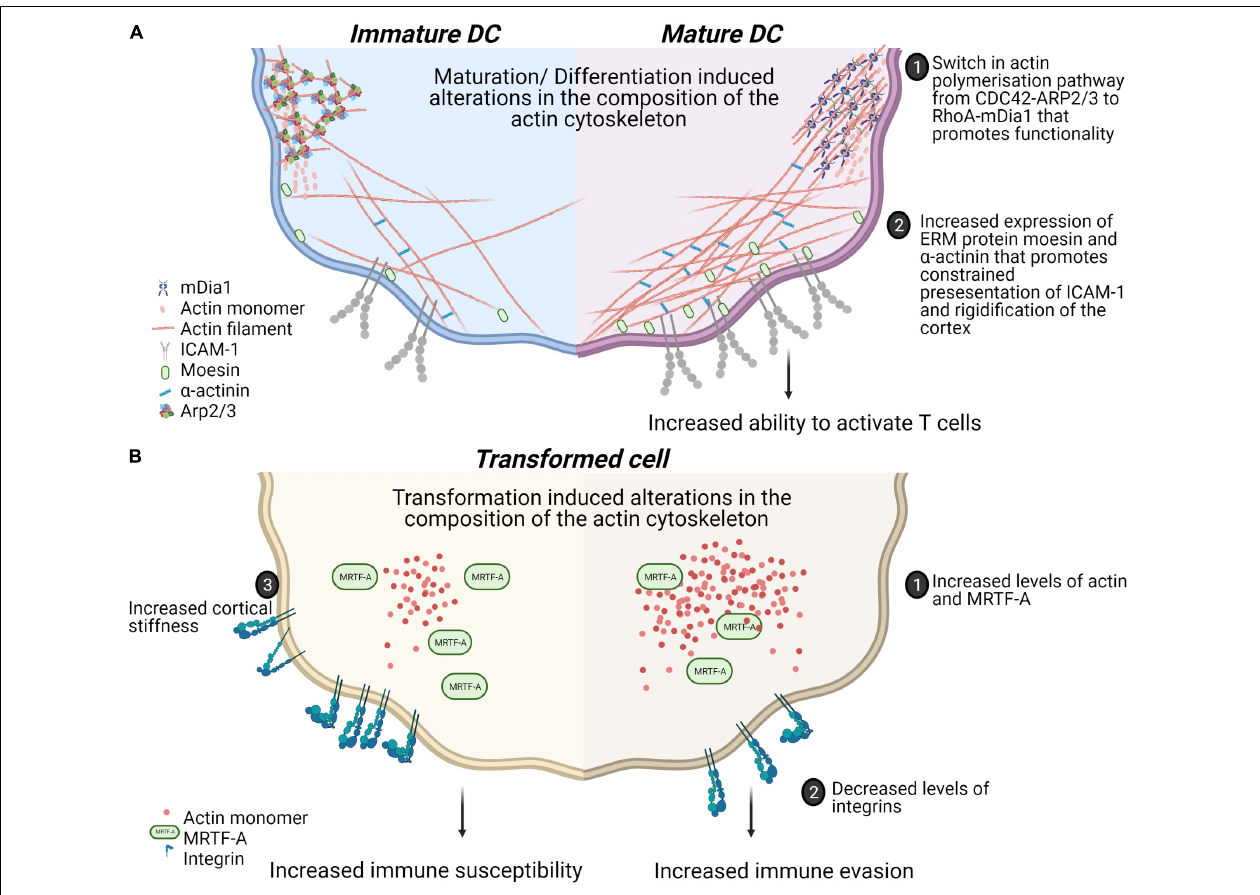
FIGURE 2 | Physiological and pathophysiological alterations in mechanical properties of immune cells alter functionality of cell-cell contacts . (A) Maturation of dendritic cells in response to Th1 polarizing antigens is associated with alterations in actin polymerization pathways. This is associated with a switch from more adherent, micropinocytosis favoring phenotype to a more migratory phenotype. These changes also include increased confinement of membrane proteins and rigidifying of the cotext that collectively enhance the activation of T cells. (B) Transformation induces changes in biophysical properties of cells through alterations in the actin cytoskeleton. Increased levels of MRTF contribute to prometastatic changes such as decreased expression of integrins and increased actin content enhancing migration. However, these adaptations could also lead to increased cortical rigidity and increased susceptibility to cytotoxic